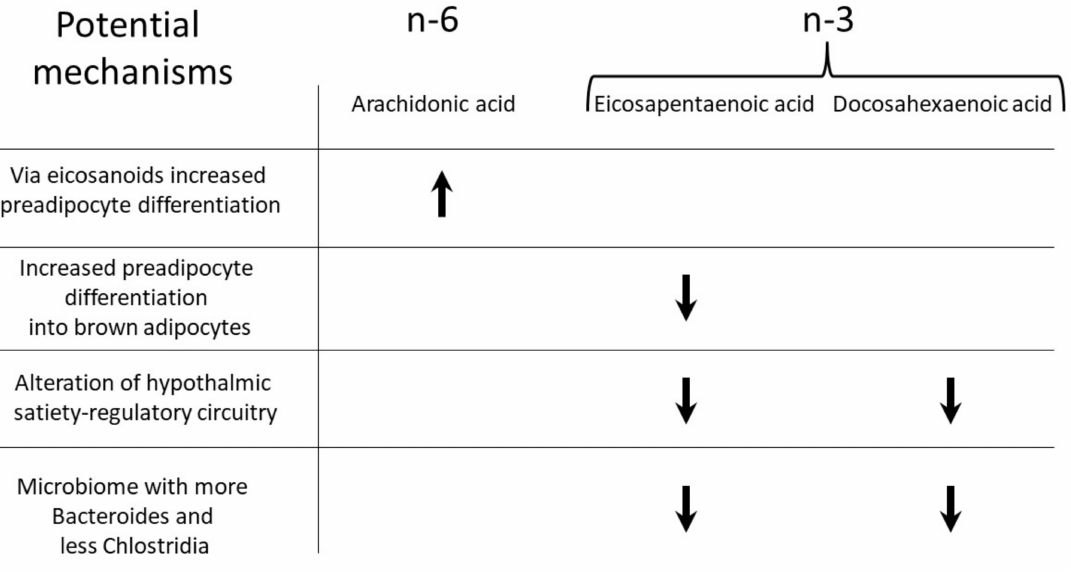
Figure 2. Outline of some of the mechanisms described in animal studies regarding how individual LC-PUFA increase ( ↑ ) or decrease ( ↓ ) the obesity risk during the perinatal